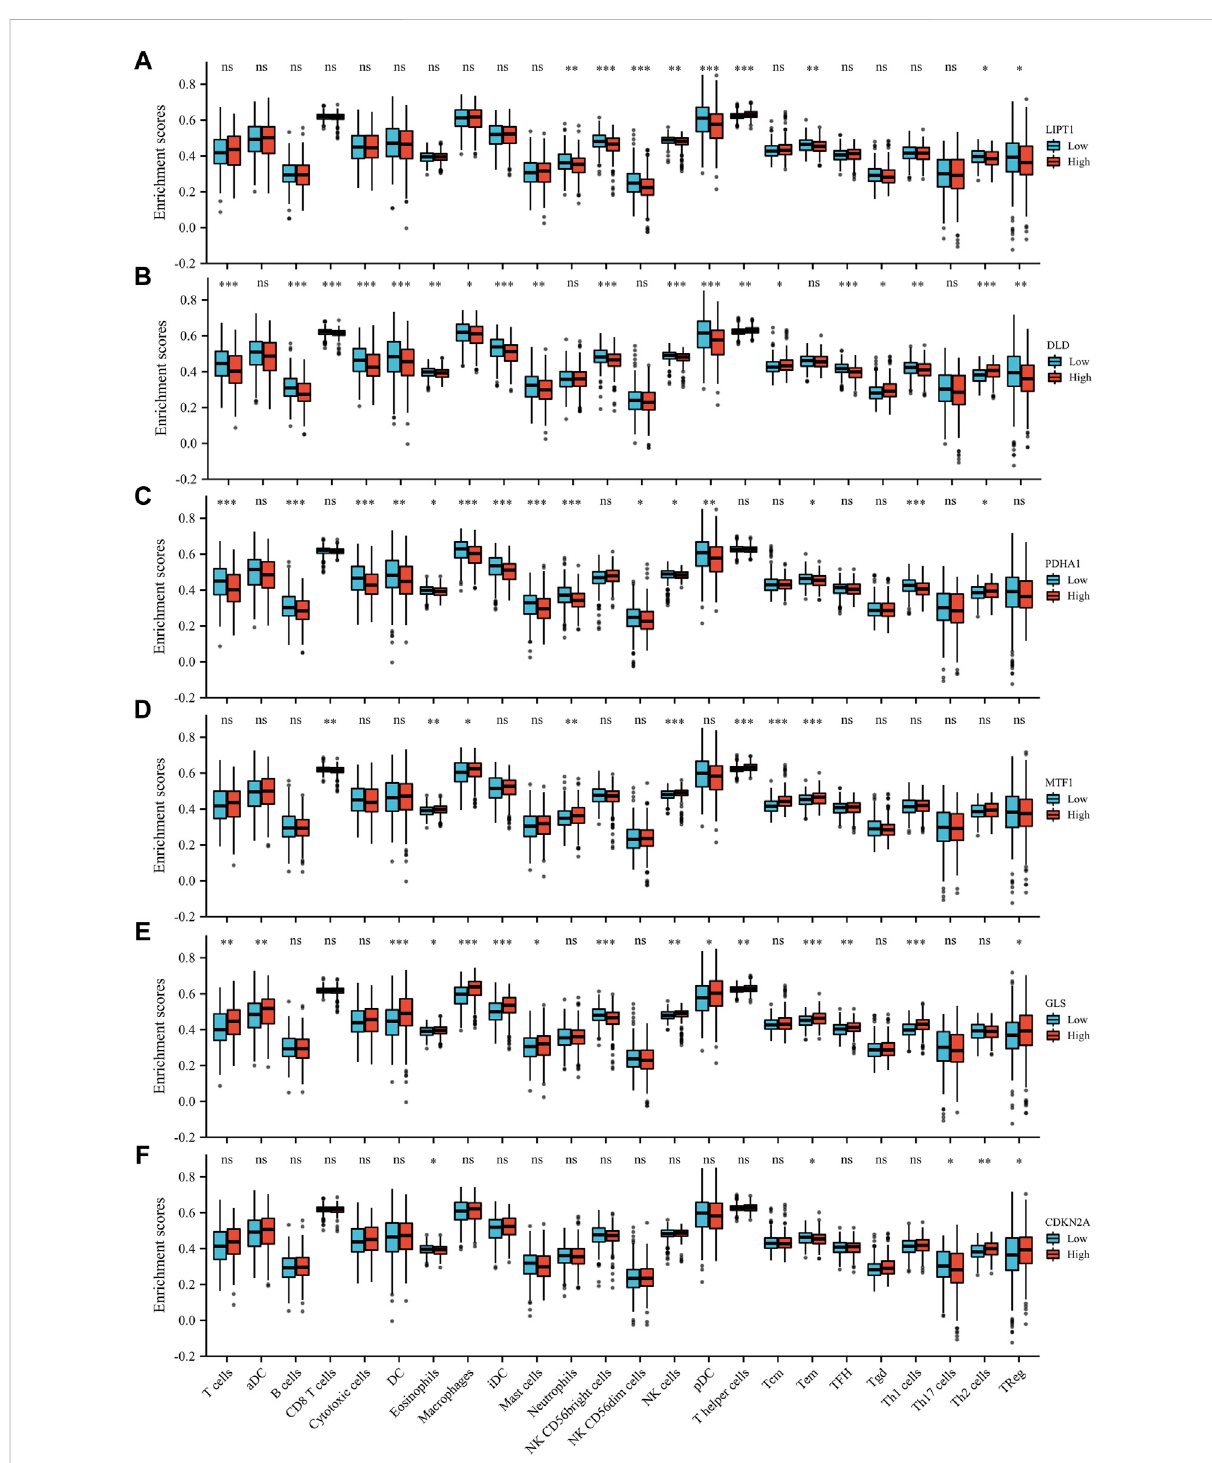
FIGURE 6 Enrichment scores of the six prognostic CRGs in 24 immune cell types in LUAD. The six prognostic CRGs were LIPT1 (A) , DLD (B) , PDHA1 (C) , MTF1 (D) , GLS (E) , and CDKN2A (F)